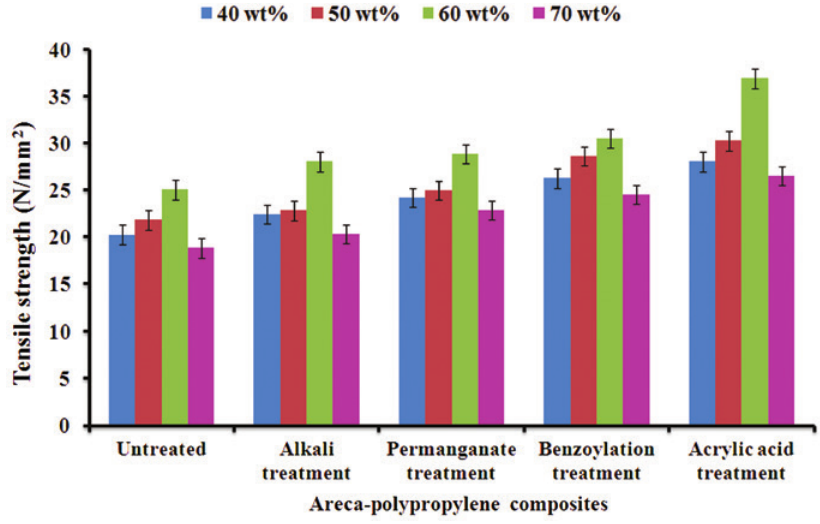
Figure 1: Tensile strength of areca-polypropylene composites with different fiber